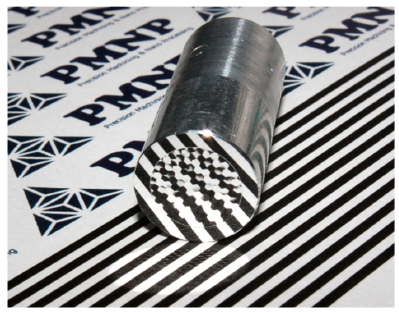
Figure 5. Photograph of a hexagonal microlens array on aluminum alloy machined by segment STS turning at N = 45 rpm.